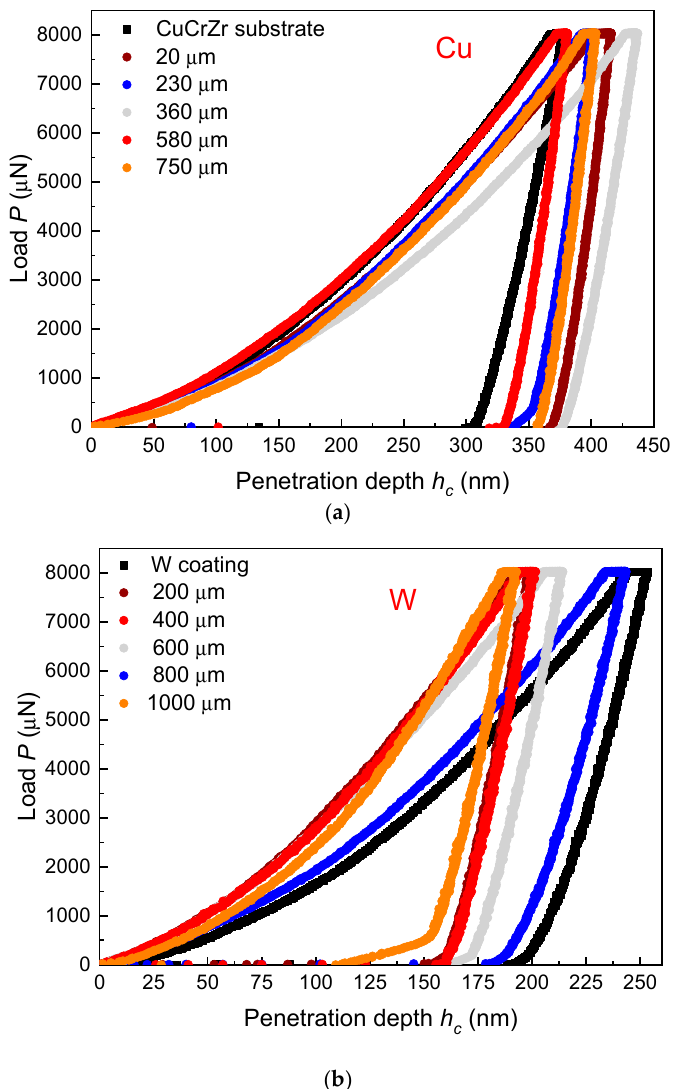
Figure 9. Some representative nano-indentation curves measured inside Cu ( a ) and W ( b ) splats in different positions of the interlayer. The distances of the imprints from the CuCrZr substrate are indicated in the